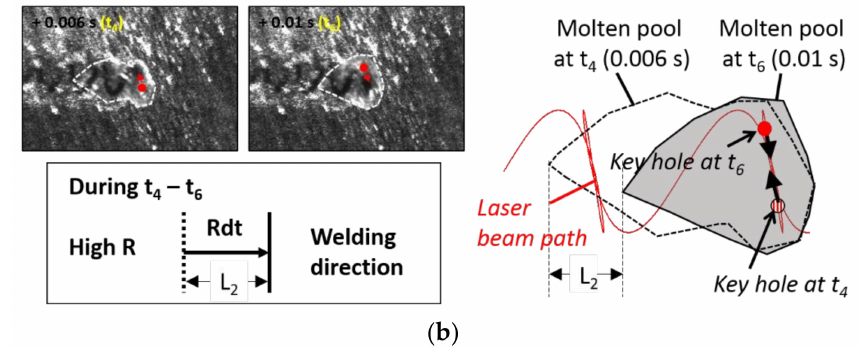
Figure 11. Schematic diagram of the molten pool movement during ( a ) t 1 –t 3 and ( b ) t 4 –t 6 , where R represents the local solidification rate, W.D is the welding direction along the x-axis, and Rdt indicates the solid–liquid interface displacement over a time interval.